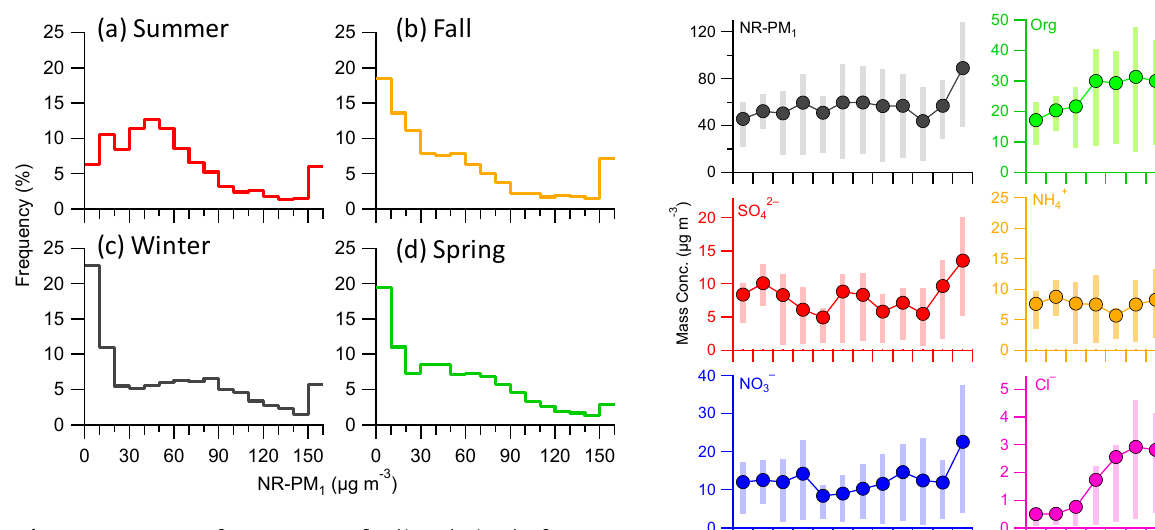
Figure 4. Frequency of NR-PM 1 mass loadings during the four sea- sons: (a) summer; (b) fall; (c) winter; (d) spring. Note that the fre- quency was calculated with 15min average data.